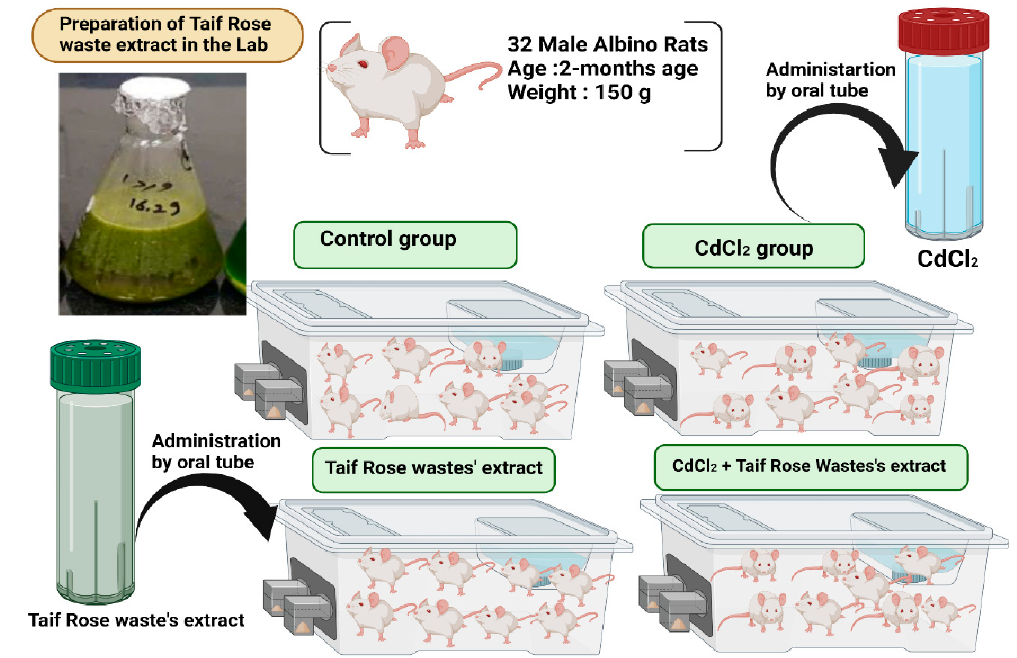
Figure 2. Experimental protocol and animal treatment groups.